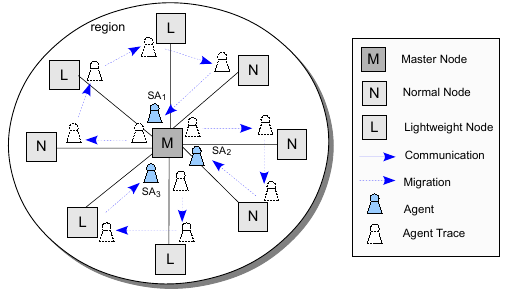
Figure 3. Scout agents collect network’s information When a scout agent arrives at a platform, it sends ping messages to all nodes of the region,